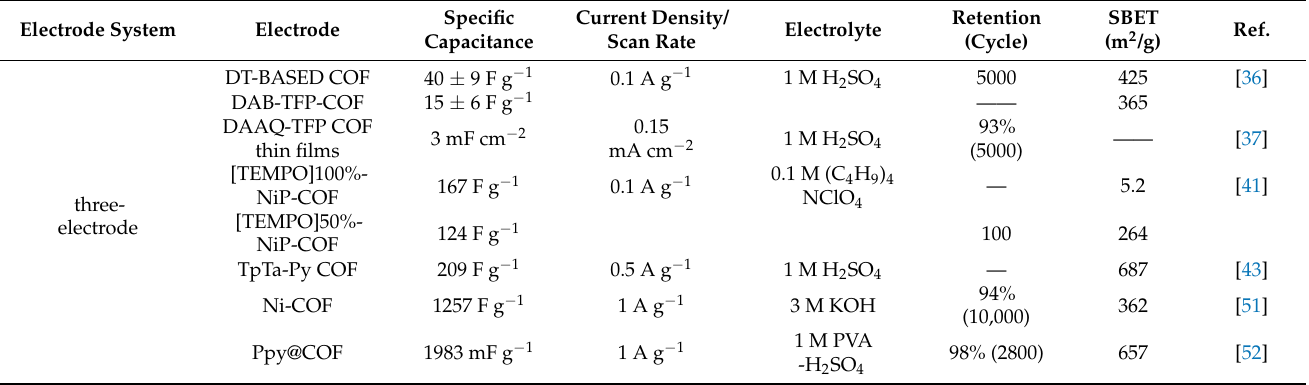
Table 1. COF-derived electrode materials and their electrochemical performance in three-electrode